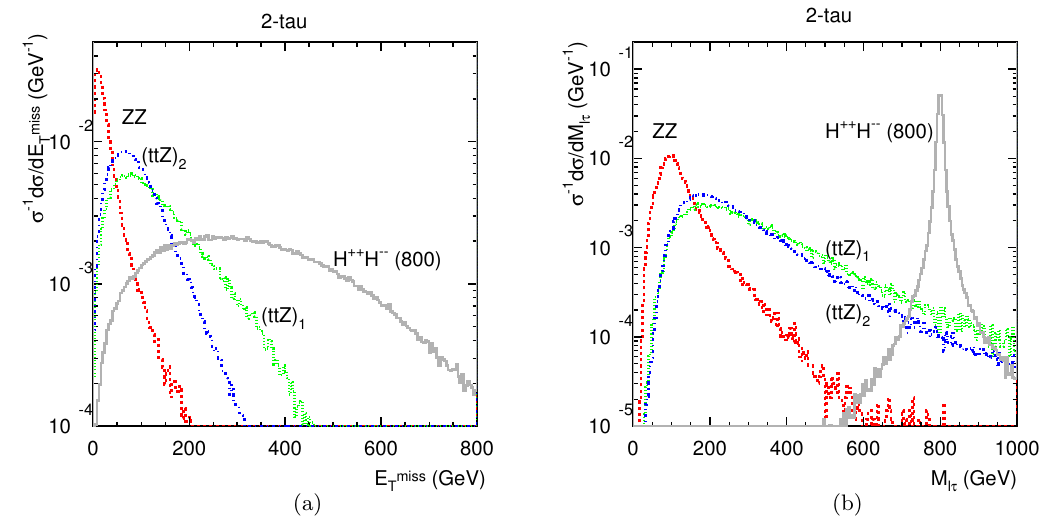
Figure 5 . The normalized di(cid:11)erential cross section distributions of signal pp ! H ++ H (cid:0)(cid:0) ! ( (cid:0) ) ‘ + (cid:28) + ‘ (cid:0) (cid:28) (cid:0) with (cid:28) (cid:6) ! (cid:25) (cid:6) (cid:23) (cid:28) and backgrounds versus (a) (cid:0) E T and (b) M We assume M = 800 H (cid:6)(cid:6)